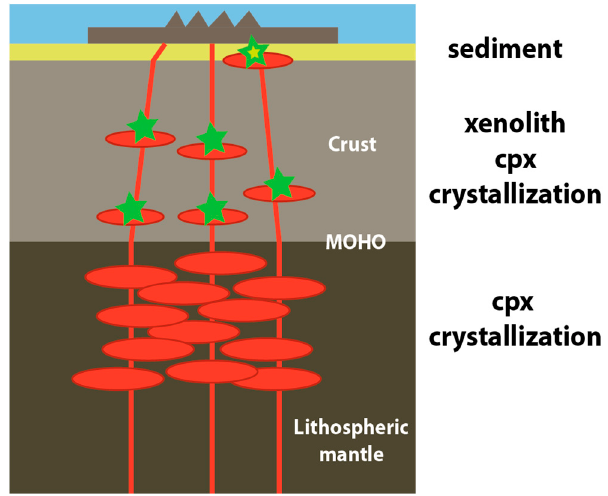
Figure 7. Schematic image of the lithospheric architecture beneath Cape Verde. The lavas crystallize clinopyroxene in the oceanic lithospheric mantle, as they traverse the ocean crust they pick up xenoliths of ocean crust that have crystallized at crustal levels. Subsequently as magma ascent proceeds the magmas cross sediments evidenced by occasional sedimentary xenoliths, before eruption at submarine volcanic centres.